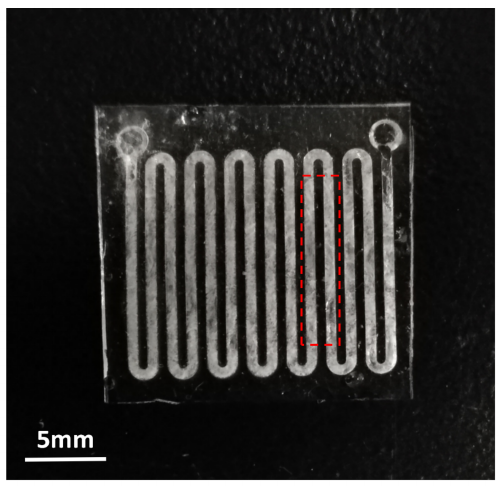
Figure 9. A PDMS-based microchannels device filled with n -Octadecane where the wireframe shows the area being cut off for DSC